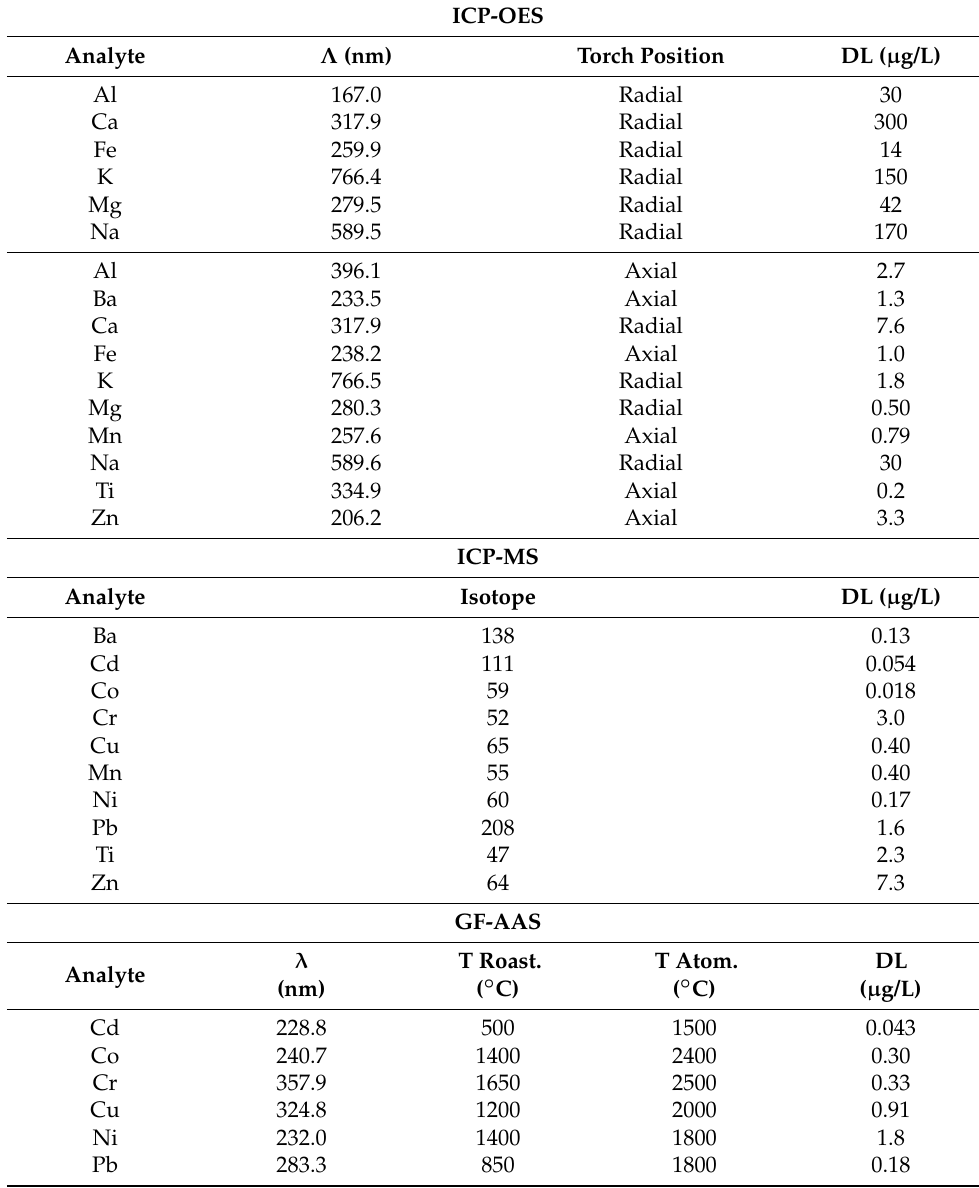
Table A3. Experimental conditions applied for ICP-OES, ICP-MS, and GF-AAS analysis and relative detection limits